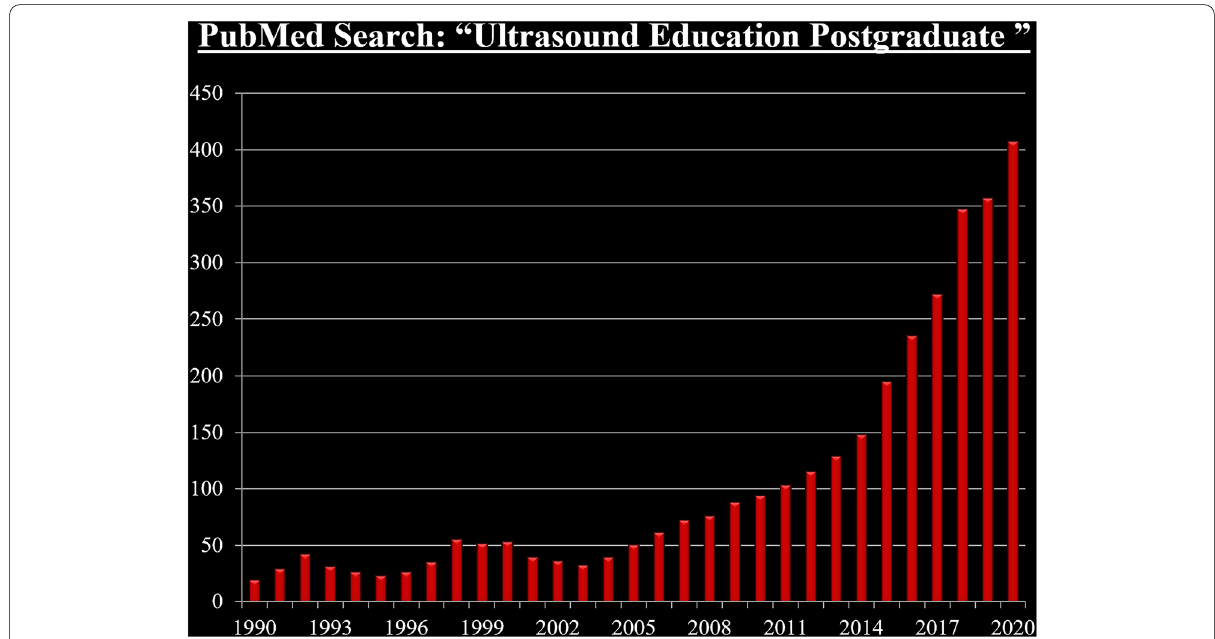
Fig. 2 A PubMed search of articles using ultrasound education postgraduate as the